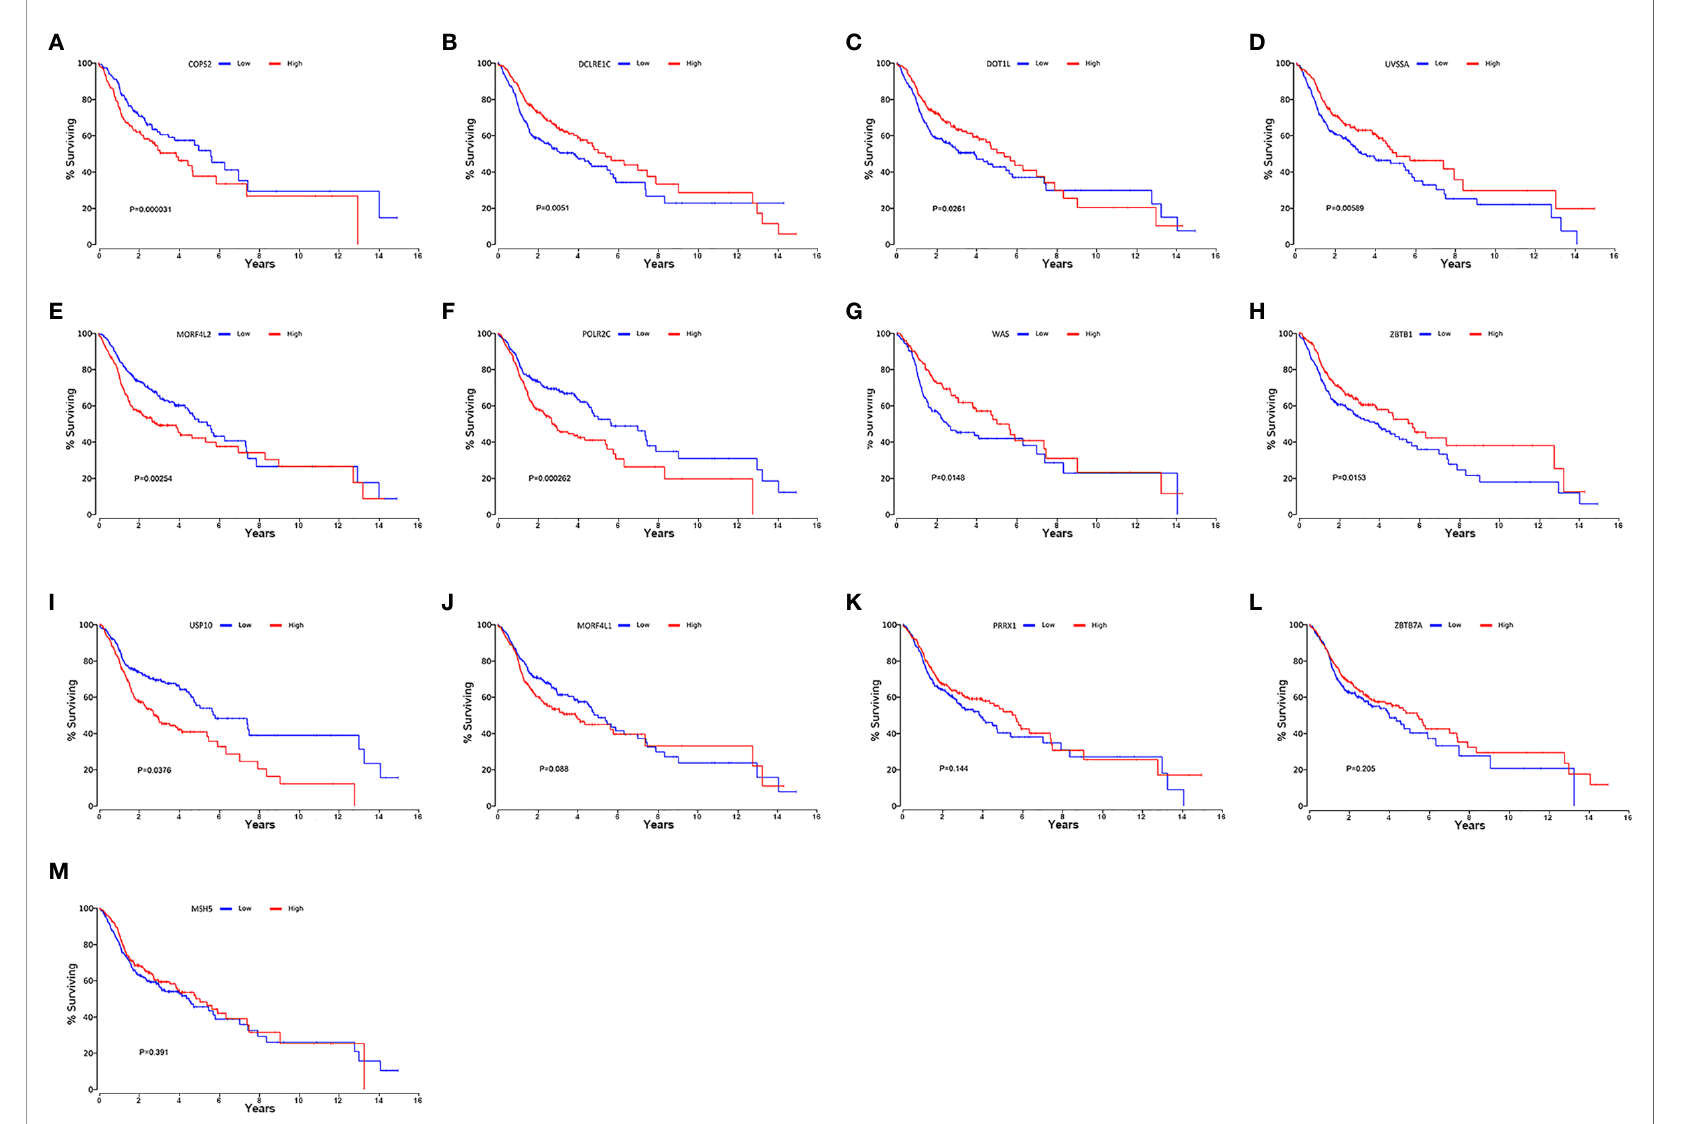
FIGURE 8 | Veri fi cation of online website Oncolnc. Kaplan-Meier survival curve from Oncolnc (http://www.oncolnc.org/) of COPS2 (A) , DCLRE1C (B) , DOT1L (C) , UVSSA (D) , MORF4L2 (E) , POLR2C (F) , WAS (G) , ZBTB1 (H) and USP10 (I) , MORF4L1 (J) , PRRX1 (K) , ZBTB7A (L) , and MSH5 (M) for